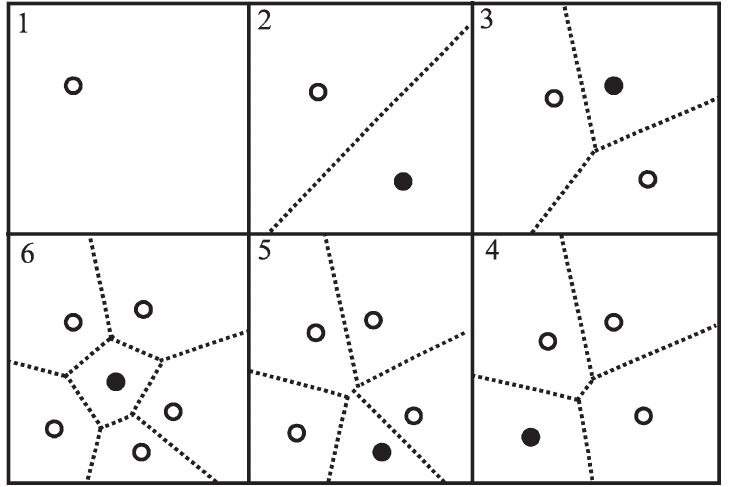
Fig. 2. Construction of a Voronoi diagram using successive addition of sites and local modification of the diagram. In each successively numbered frame, the solid circle represents the newly considered site. New bisectors are drawn between existing neighbour sites (open circles) and existing lines are cropped according to their relative